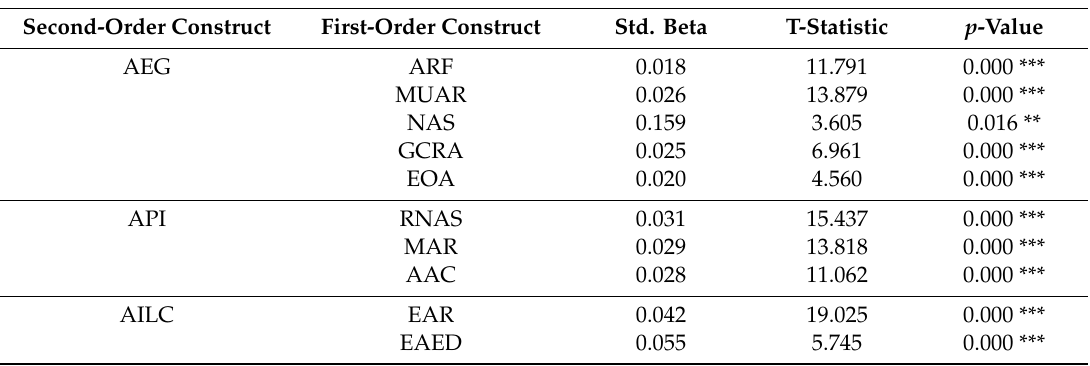
Table 3. Formation of second-order constructs AEG, API, and